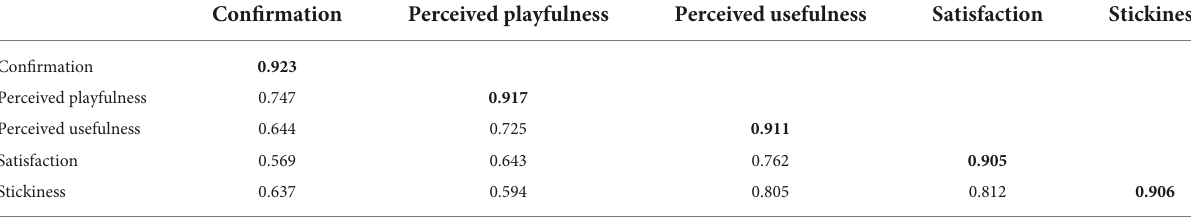
TABLE 4 Fornell and